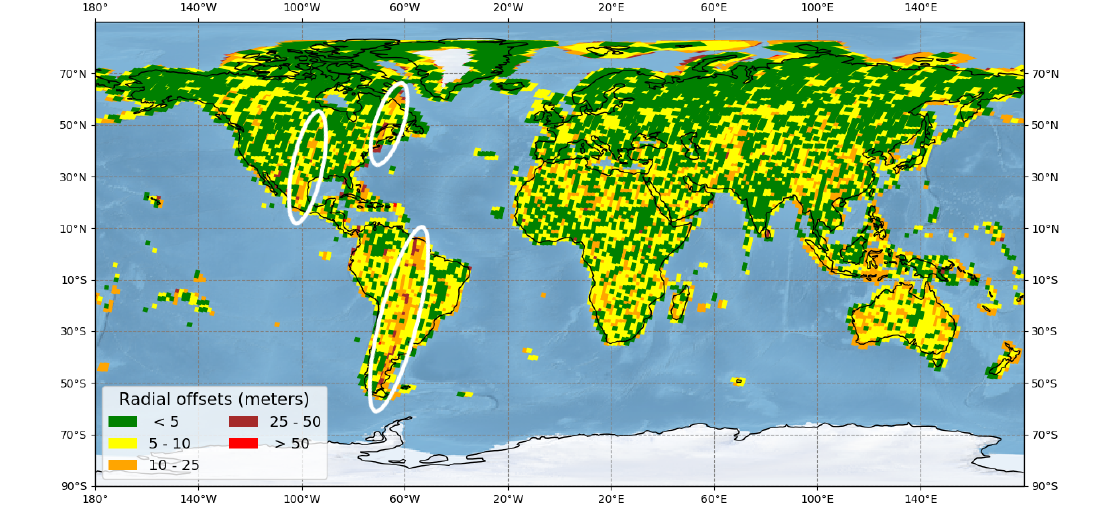
Figure 9. Radial geodetic offsets of the L8 scenes processed using the updated